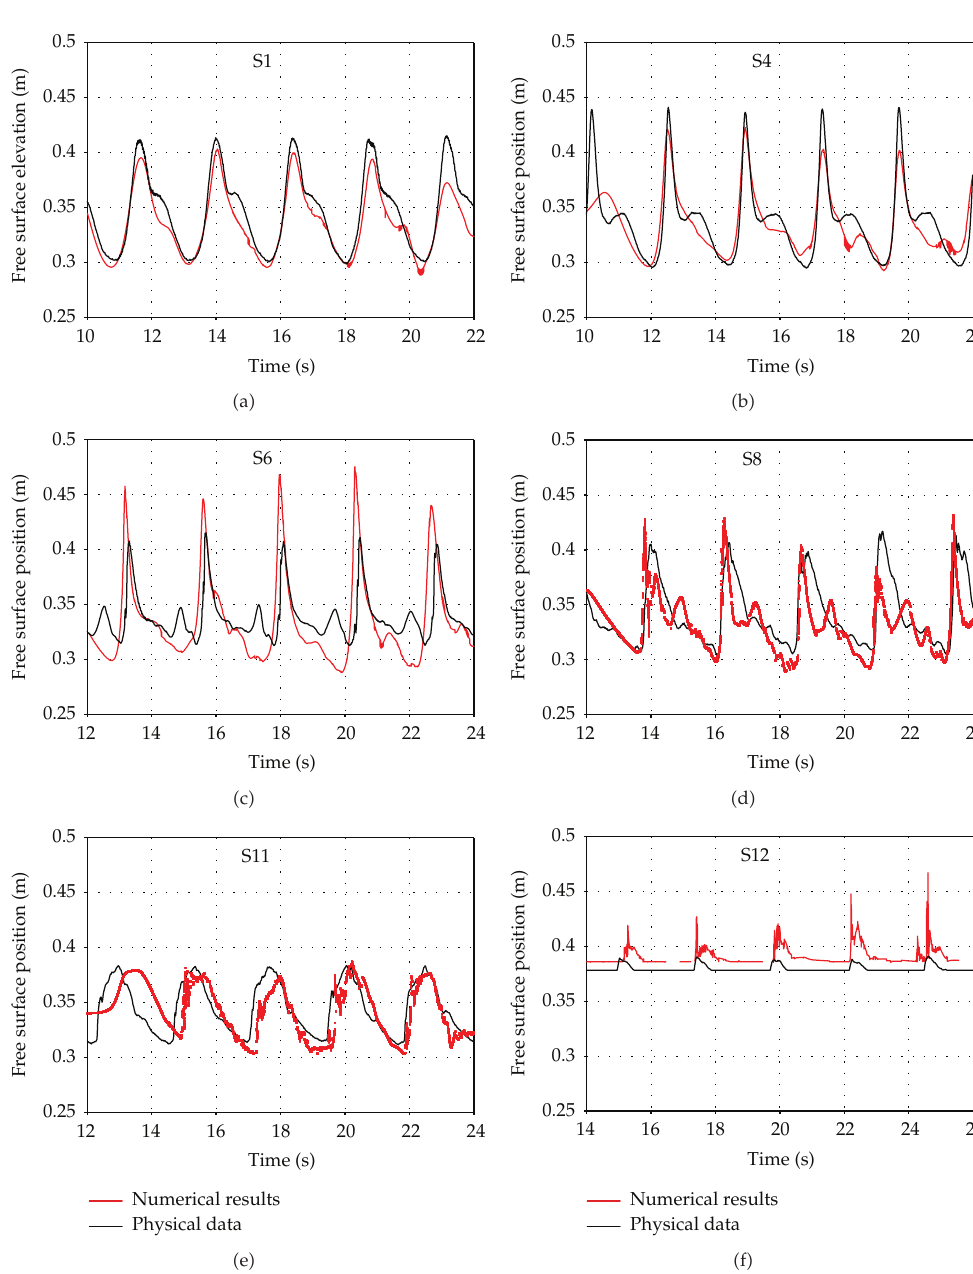
Figure 11: Numerical and physical free surface comparison at six di ff erent locations, corresponding to the case with a still water level of